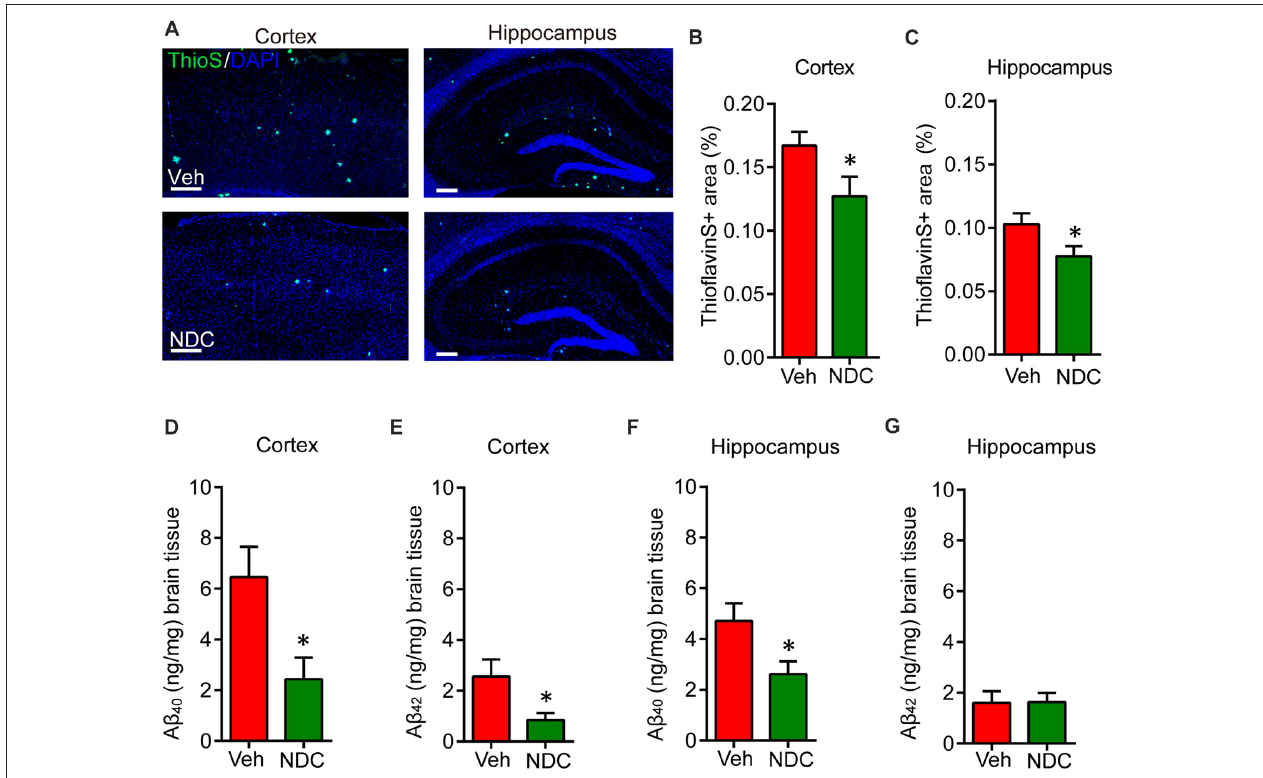
FIGURE 3 | NDC alleviates amyloid plaque burden and A β levels in APP/PS1 mice. (A) Representative half brain sections of vehicle- or NDC-treated APP/PS1 mice brain stained with ThioS and DAPI in cortex and hippocampus are shown. Scale bar = 200 µ m. (B,C) Quantitative analysis of the of ThioS-positive amyloid plaques covered area in cortex (B) and hippocampus (C) . (D,E) ELISA of soluble A β 40 and A β 42 levels in cortical tissues of APP/PS1 mice. (F,G) ELISA of soluble A β 40 and A β 42 levels in hippocampal tissues of APP/PS1 mice. Data are presented as mean ± SEM. ThioS: Veh group n = 5, NDC group n = 5; ELISA: Veh group n = 6, NDC group n = 6. ∗ p < 0.05, analyzed by two-tailed t test compared with APP/PS1 vehicle group.